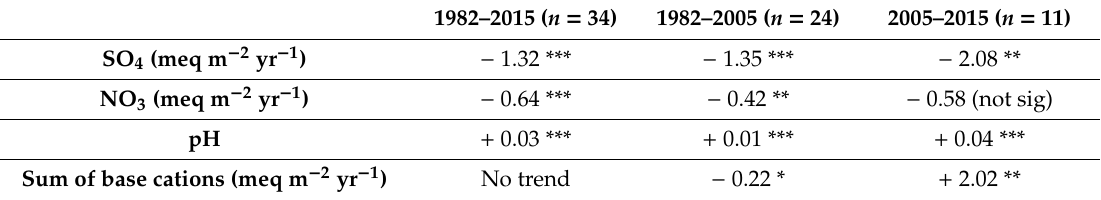
Figure 2. Bulk deposition of nitrate-N, sulphate, sum of base cations (Ca + Mg + K + Na) and pH between 1980 and 2017 in the study region. Table 1. Trends in bulk deposition chemistry. Asterisks indicate significance; *** < 0.001 ** < 0.05 * <